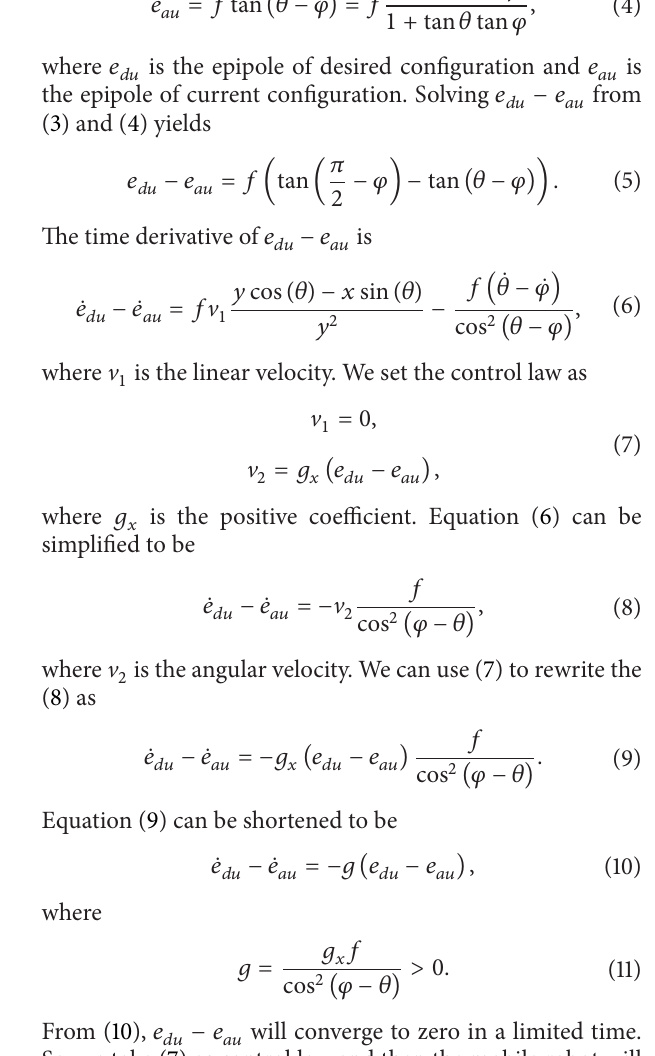
Figure 2: The nonholonomic robot with two independently derived